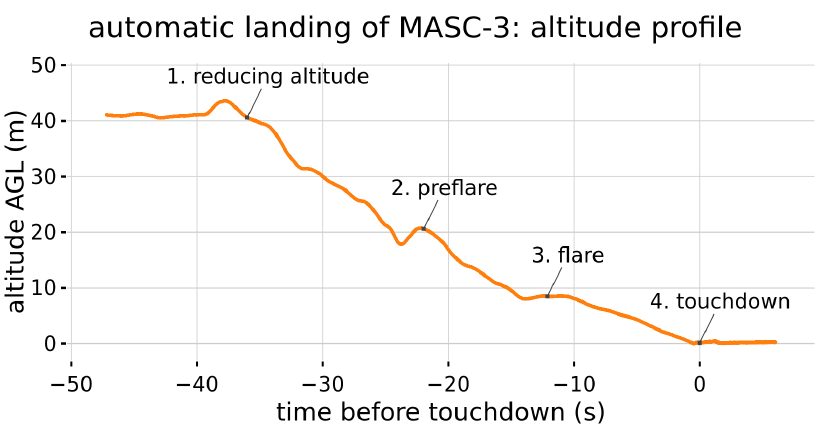
Figure 2. MASC-3 altitude profile during automatic landing